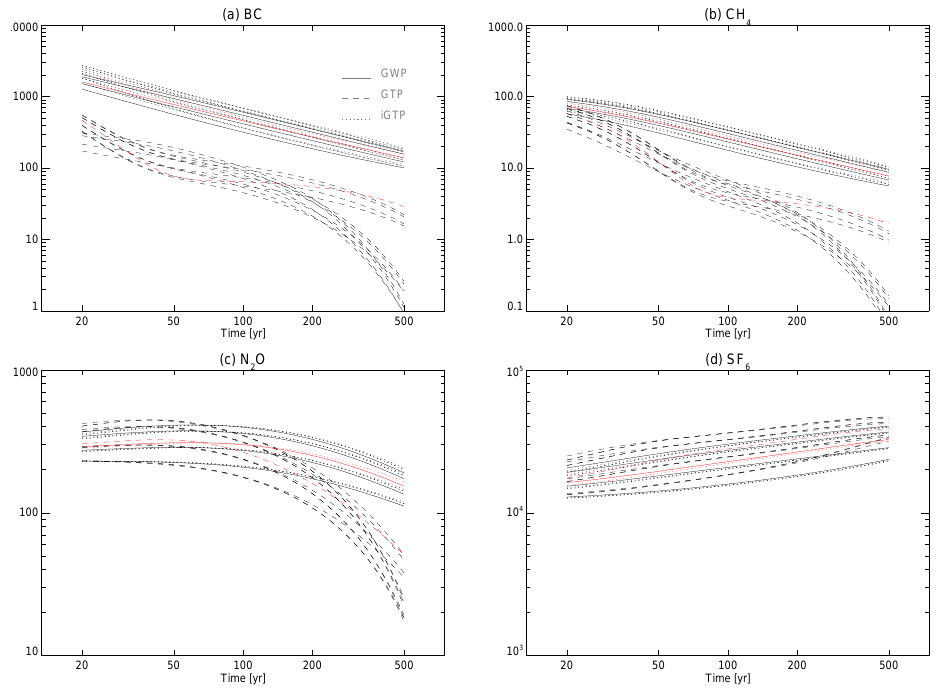
Fig. 3. Evolution of GWP (full line), GTP (dashed line), and iGTP (dotted line) as a function of the time horizon for (a) BC, (b) CH 4 , (c) N 2 O, and (d) SF 6 , using different combinations of IRF CO 2 and IRF T . The black curves correspond with all combinations of IRF CO 2 distributions (C 4 MIP(u), C 4 MIP(c), LTMIP, and J13) and IRF T distributions (CMIP3, CMIP3*, and CMIP5) – the lines shown are the median values of the obtained metric distributions. The red lines are the result of the combination of the reference IRF CO 2 J07 and IRF T BR08. The vertical axis is dimensionless.